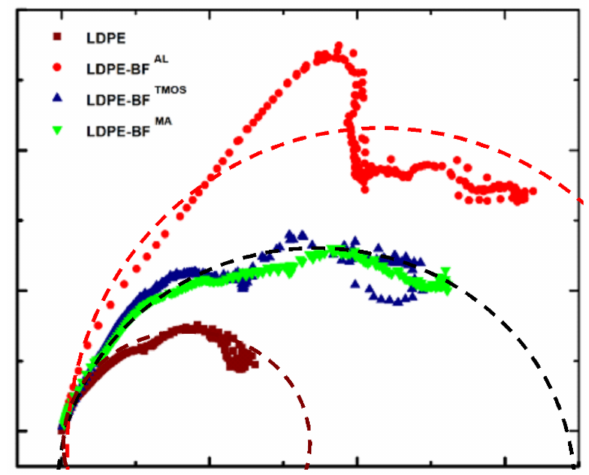
Figure 13. Cole-Cole plots for LDPE with different coupling agents and bamboo fibers; indicator for durability for composite; dot semicircles represent the analytical models of the Cole-Cole plots using h and k parameters [23] for each combination of LDPD and BFs. Deviation from the semicircle qualitatively indicates the anisotropy produced by the fibers and the coupling